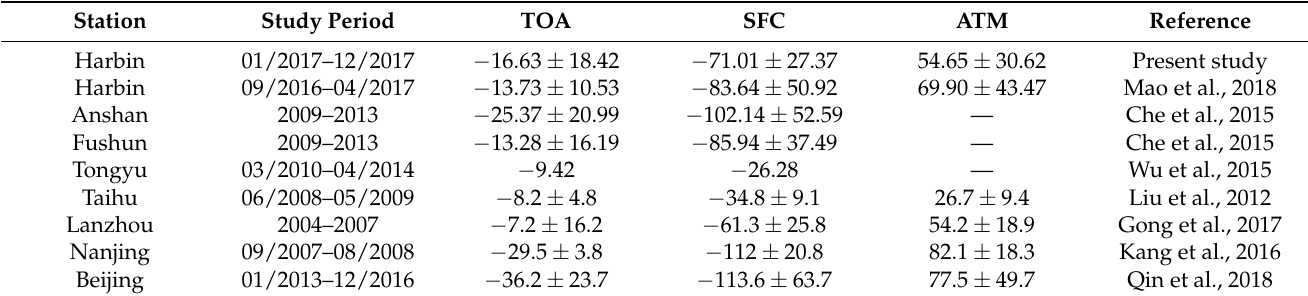
Table 3. The ARF in this paper and other previous studies in different regions of